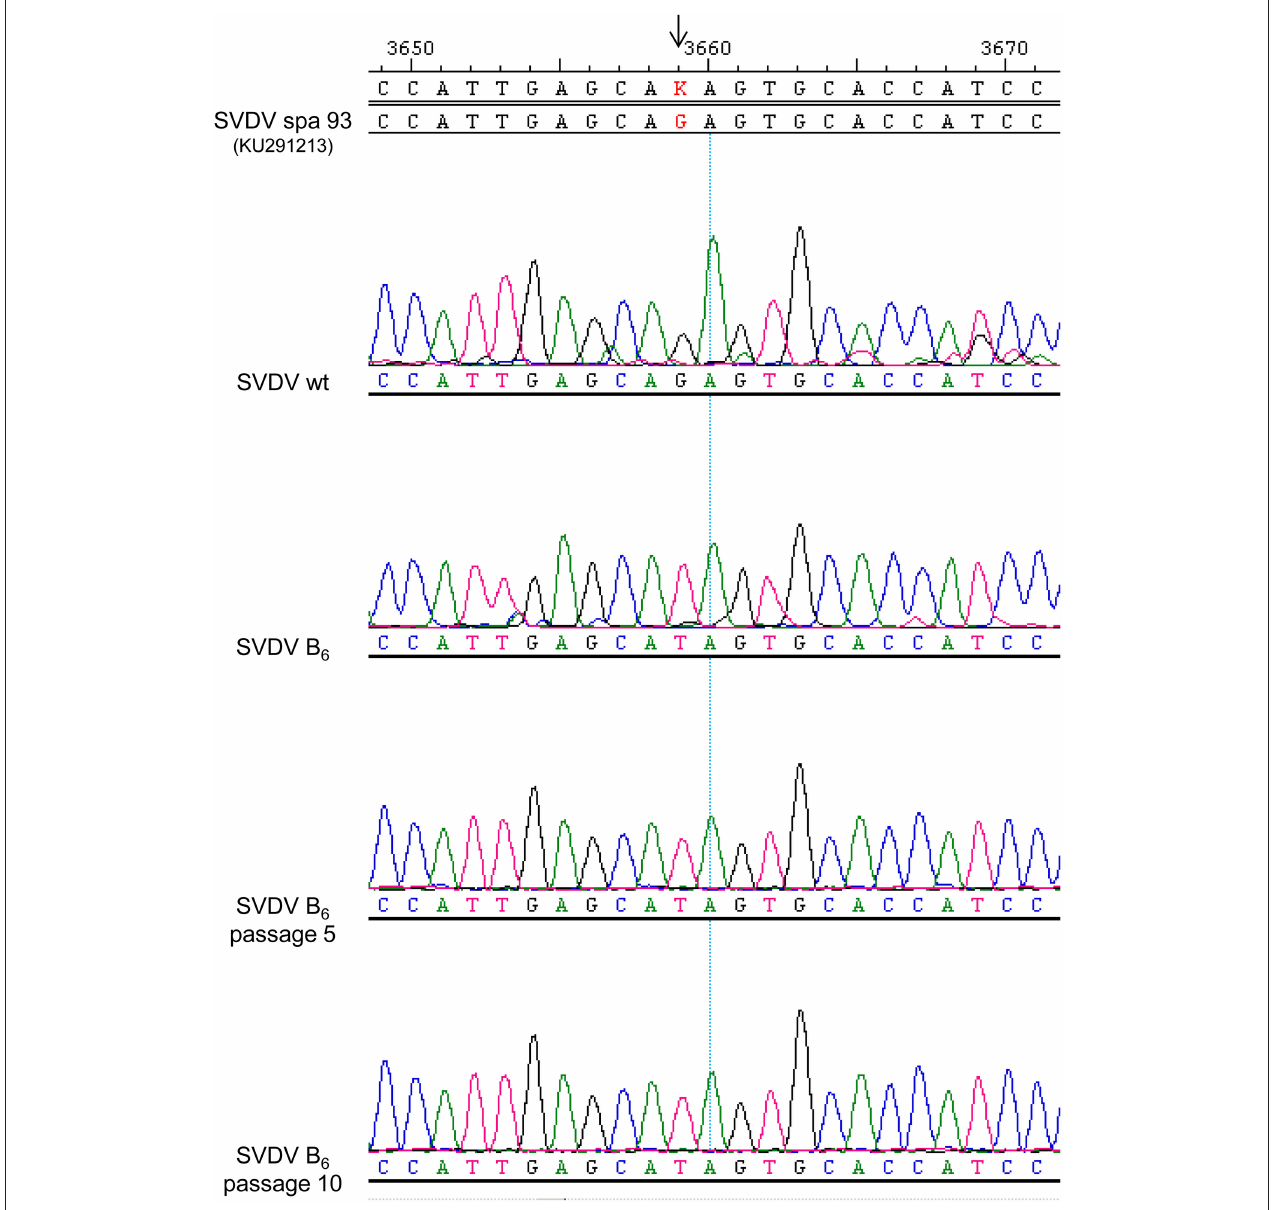
FIGURE 5 | Genetic stability of the nucleotide replacement G3659T. SVDV B 6 was passaged ten times in absence of BFA. The viral RNA of the passages 5 and 10 was extracted and the nucleotide sequence was determined. Representative chromatograms of the region encoding 2C protein are shown of SVDV wt, SVDV B 6 , SVDV B 6 passage 5 and SVDV B 6 passage